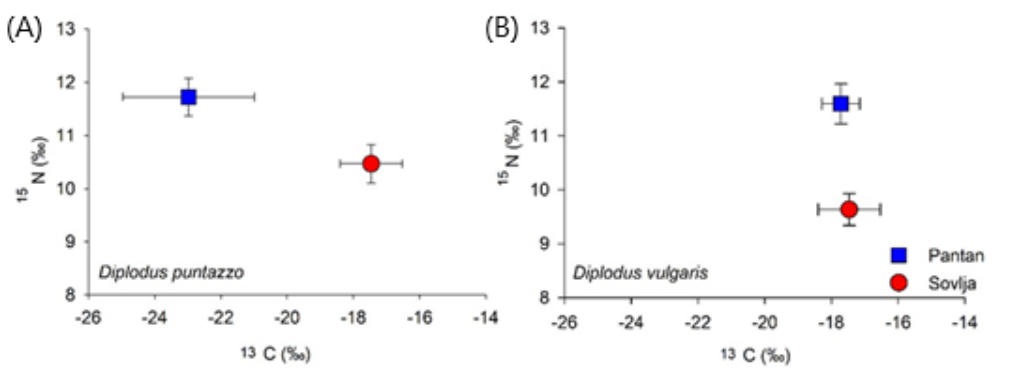
Figure 4. Plots of median (and standard deviation) of δ 13 C and δ 15 N ratio muscle tissue of D. puntazzo ( A ) and D. vulgaris ( B ) collected from the Pantan estuarine site and Sovlja coastal site.